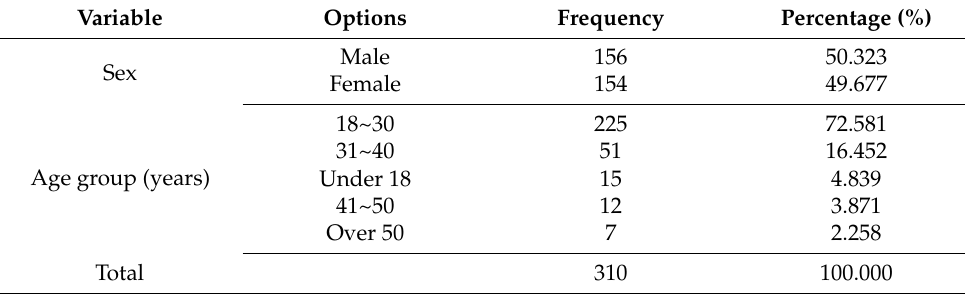
Table 3. Basic information of the questionnaire